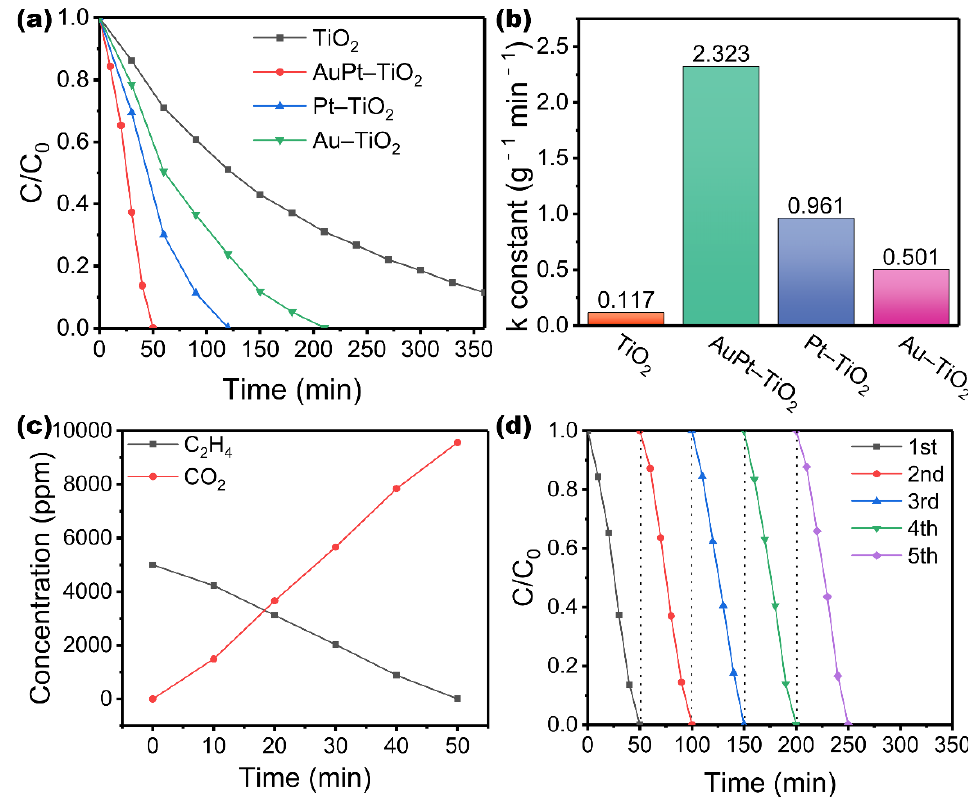
Figure 4. Under UV – vis light irradiation, ( a ) ethylene photodegradation curves and ( b ) reaction rate Figure 4. Under UV–vis light irradiation, ( a ) ethylene photodegradation curves and ( b ) reaction constants of pure TiO 2 , AuPt – TiO 2 , Pt – TiO 2 and Au – TiO 2 samples, ( c ) concentration curves of eth- rate constants of pure TiO 2 , AuPt–TiO 2 , Pt–TiO 2 and Au–TiO 2 samples, ( c ) concentration curves of ylene and carbon dioxide during photodegradation for AuPt – TiO 2 and ( d ) five consecutive cycles ’ ethylene and carbon dioxide during photodegradation for AuPt–TiO 2 and ( d ) five consecutive cycles’ stability of photocatalytic activity of AuPt – TiO 2 for ethylene degradation. stability of photocatalytic activity of AuPt–TiO 2 for ethylene